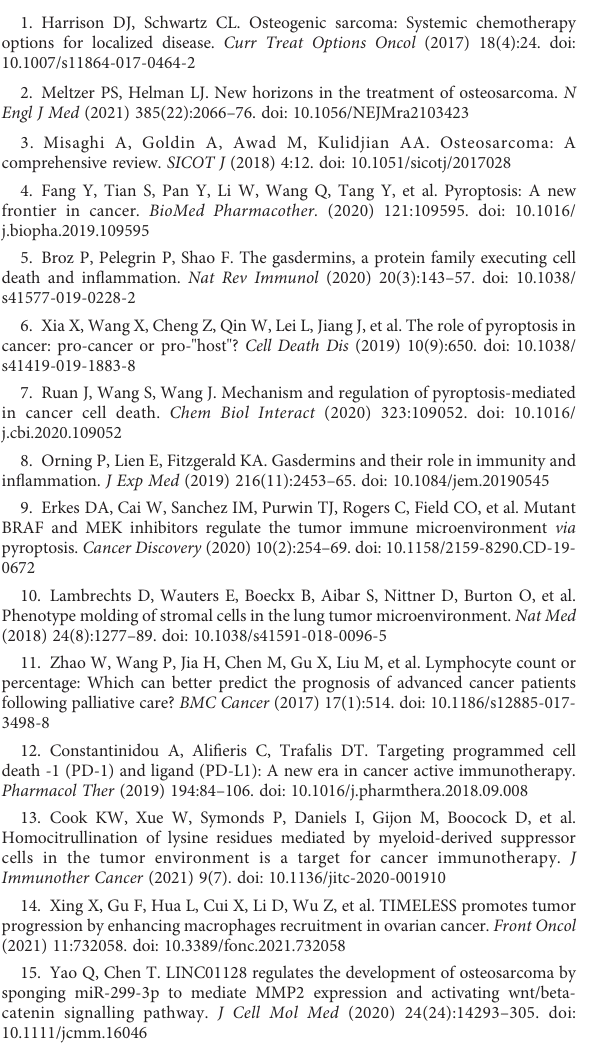
Consensus matrix heatmap de fi ning two clusters (k = 3) in TARGET and GSE21257 cohort based on DEGs expression.